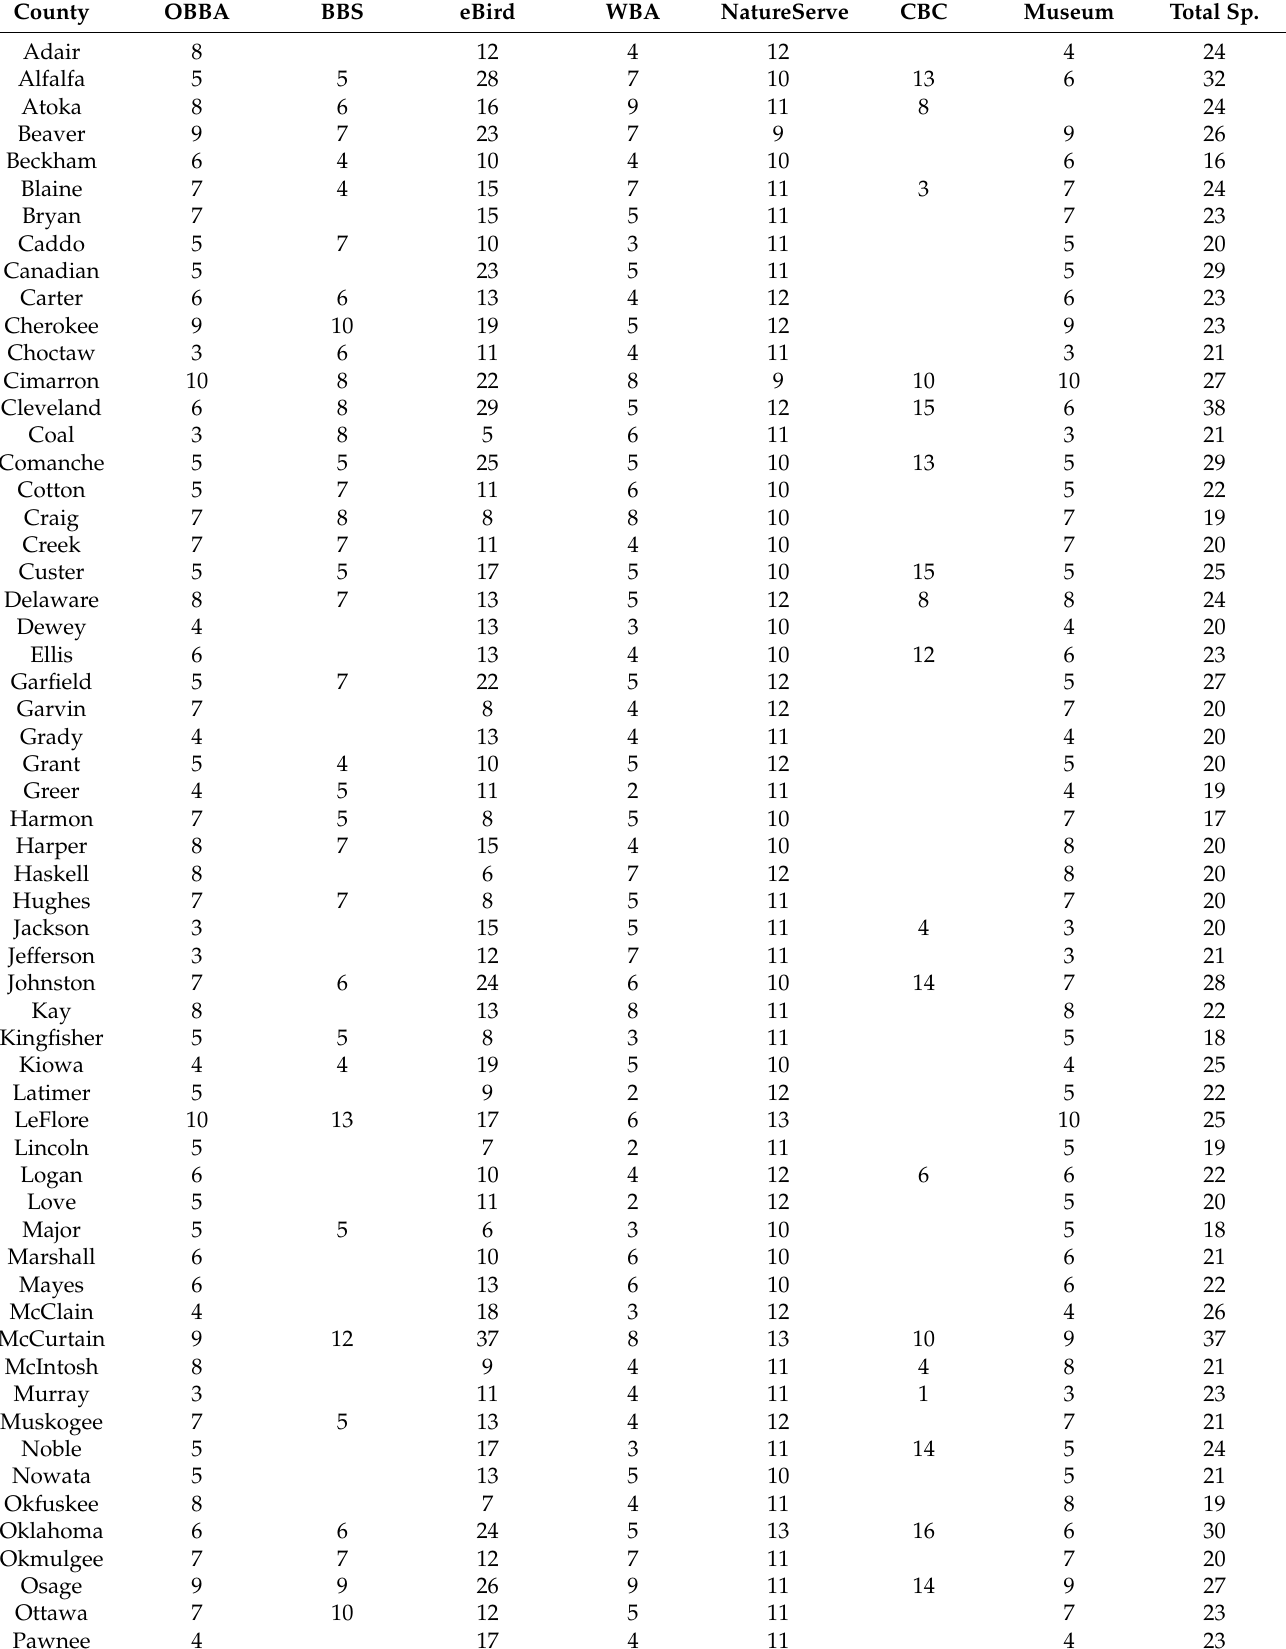
Table 4. Total number of species of conservation concern recorded by each method for the 77 counties in